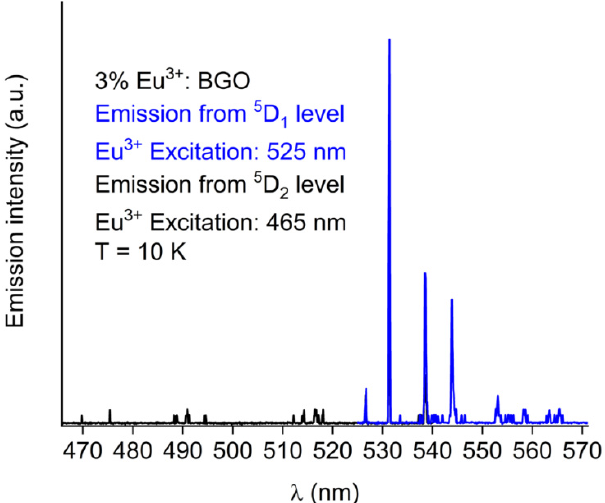
Figure 5. 5 D 0 level emission spectra of BGO: 3% Eu 3 + . Figure 5 . 5 D 0 level emission spectra of BGO: 3% Eu 3+ .